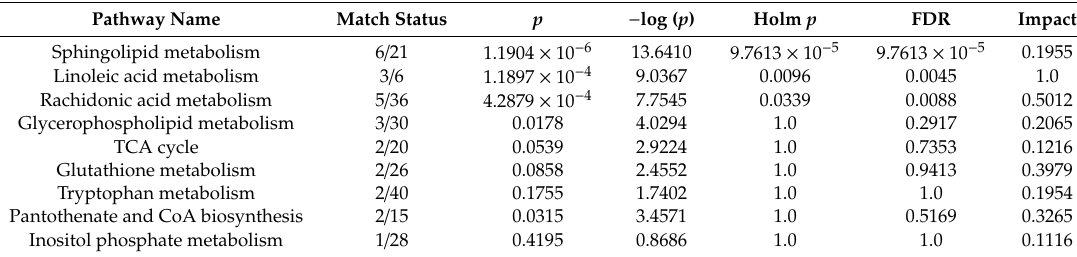
Table 3. Metabolic pathways of di ff erential